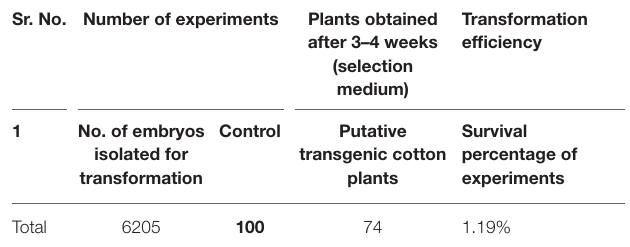
TABLE 3 | Efficiency of transformation. Sr. No. Number of